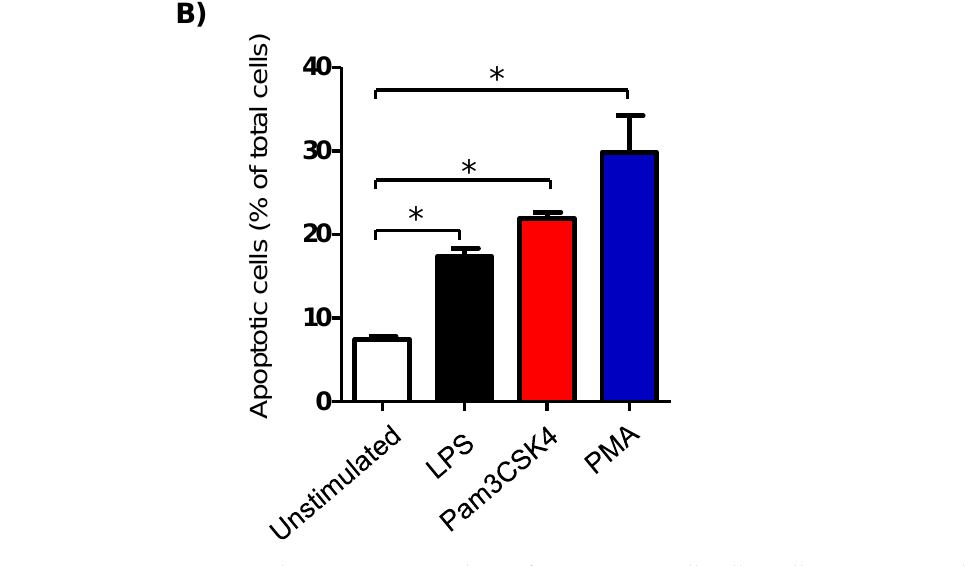
Figure 2. Flow cytometric analysis of apoptosis in milk cells. Cells were separated from unstimulated and stimulated milk samples, stained with JC-1, and analyzed by flow cytometry. ( A ) Apoptotic cells (with JC-1 monomers) were differentiated from viable cells (with JC-1 aggregates) based on their emission in the green (FL1) and orange fluorescence channels (FL2), respectively, upon excitation at 488 nm. ( B ) Data were calculated for stimulated and unstimulated milk cells and presented graphically. * indicates statistically significant differences between the groups ( n = 7 camels; p values less than 0.05).